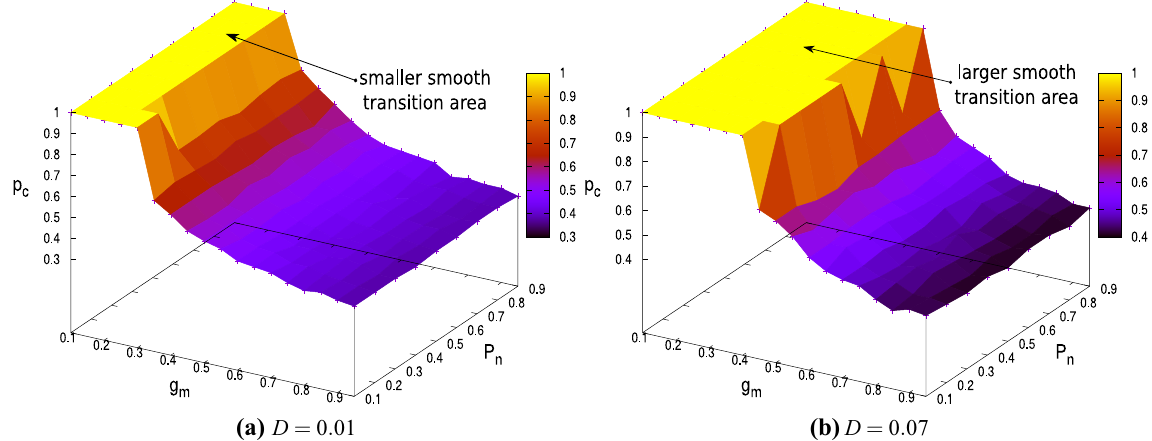
Figure 9. The critical inactivation probability p c plotted as a function of g m and P n for ( a ) D = 0.01 and ( b ) D = 0.07